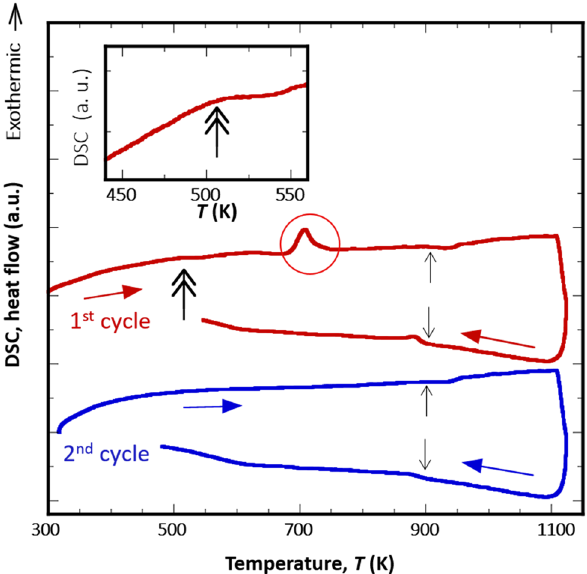
Figure 2. DSC results. Cyclic DSC heating and cooling curves for (CrFe)S synthesised by sintering and quenching, measured at the heating and cooling rates of 10 K/min. The exothermic peak at 700 K in the first heating curve (marked by solid circle) was attributed to the decomposition of the NiAs-type (CrFe)S phase. The single arrows at approximately 900 K and double arrow at 510 K (see the magnified curve in the inset) correspond to the recomposition of α-Fe and (Cr , Fe) 3 S 4 , and T C , respectively.